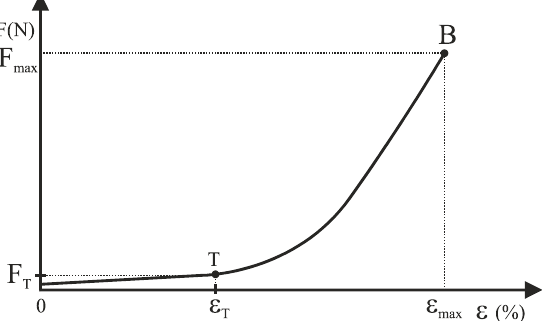
Figure 2. The typical load-elongation (F − ε ) diagram of knitted fabric.